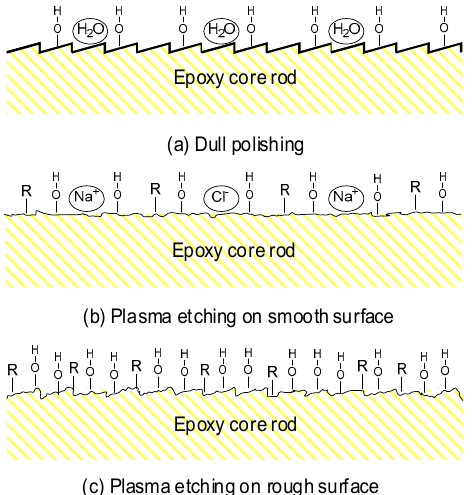
Figure 9. Mechanisms for the improved interface performance of composite insulator by plasma etching. ( a ) The surface molecular structure of blunt polished material; ( b ) The molecular structure of the material surface etched by plasma on a smooth surface; ( c ) Rough surface plasma etched material surface molecular structure.